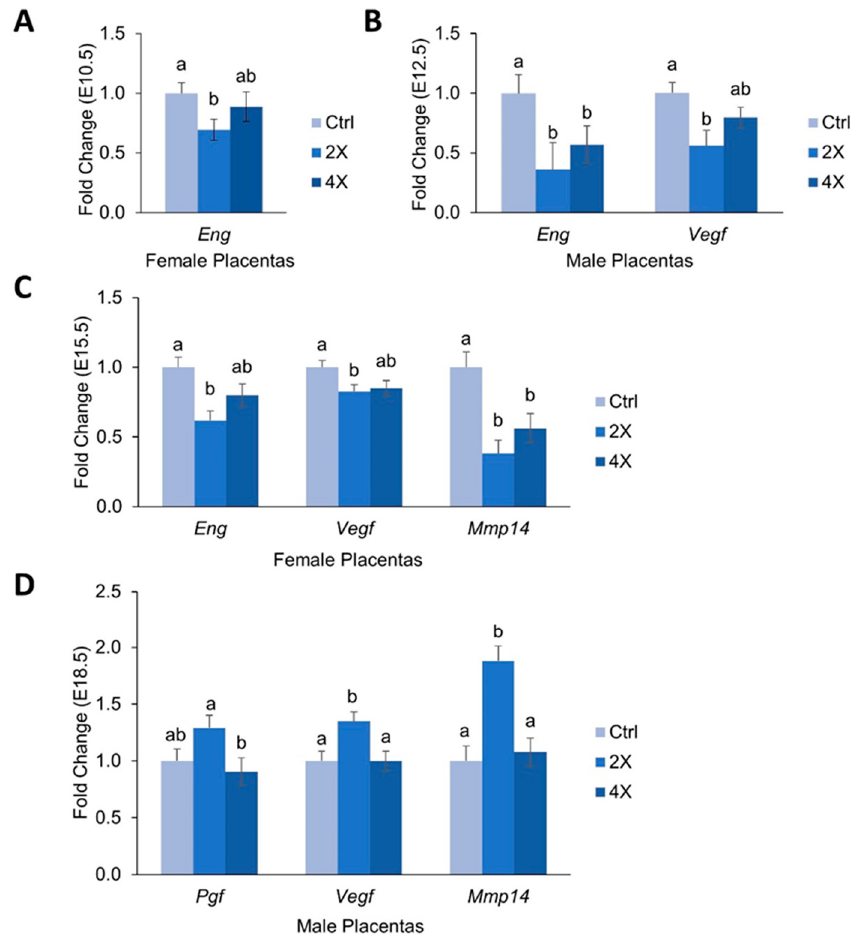
Figure 3. Placental mRNA abundance of angiogenic genes at ( A ) E10.5, ( B ) E12.5, ( C ) E15.5, and ( D ) E18.5 by maternal choline treatment. Data are expressed as the fold-change relative to the housekeeping gene Tbp . Data were analyzed using mixed linear models with choline treatment as a fixed effect and maternal ID as a random effect. Litter size and fetal genotype (for E10.5; heterozygous pups were used for E12.5, E15.5, and E18.5) were controlled for in the models as fixed effects. Values are presented as mean ± SEM. Different letters denote significant differences between means of the treatments at p ≤ 0.05. n = 20 placentas per treatment per time point.